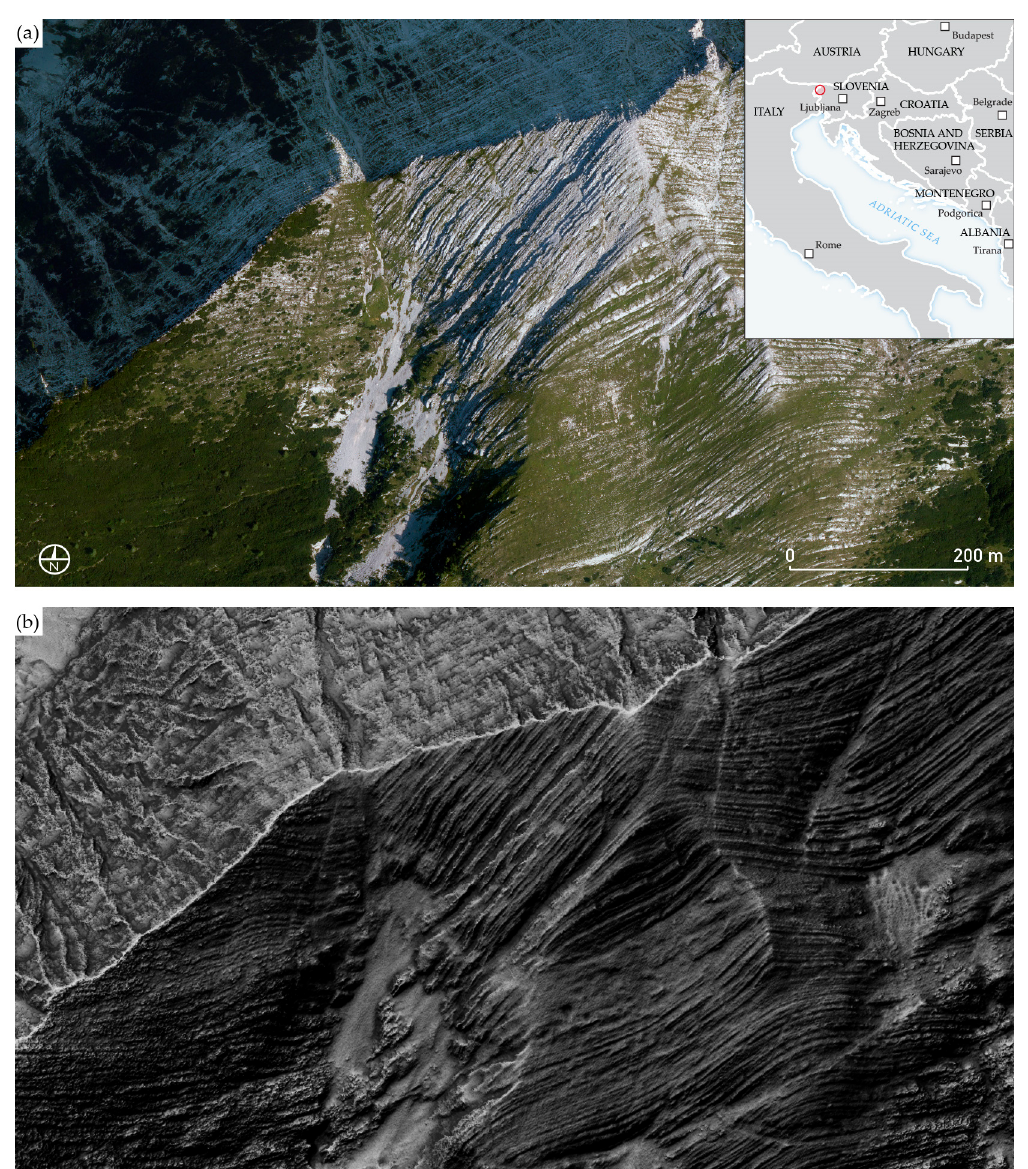
Figure 5. Dachstein limestone strata and scree fields exposed at Vrh Brda (1952 m) as seen on ( a ) an orthophoto image (GURS 2017) and ( b ) the visualization for archaeological topography. The top of the ridge is highlighted in white and the intricate geomorphological details are clearly visible. 1 m resolution ALS data © ARSO.